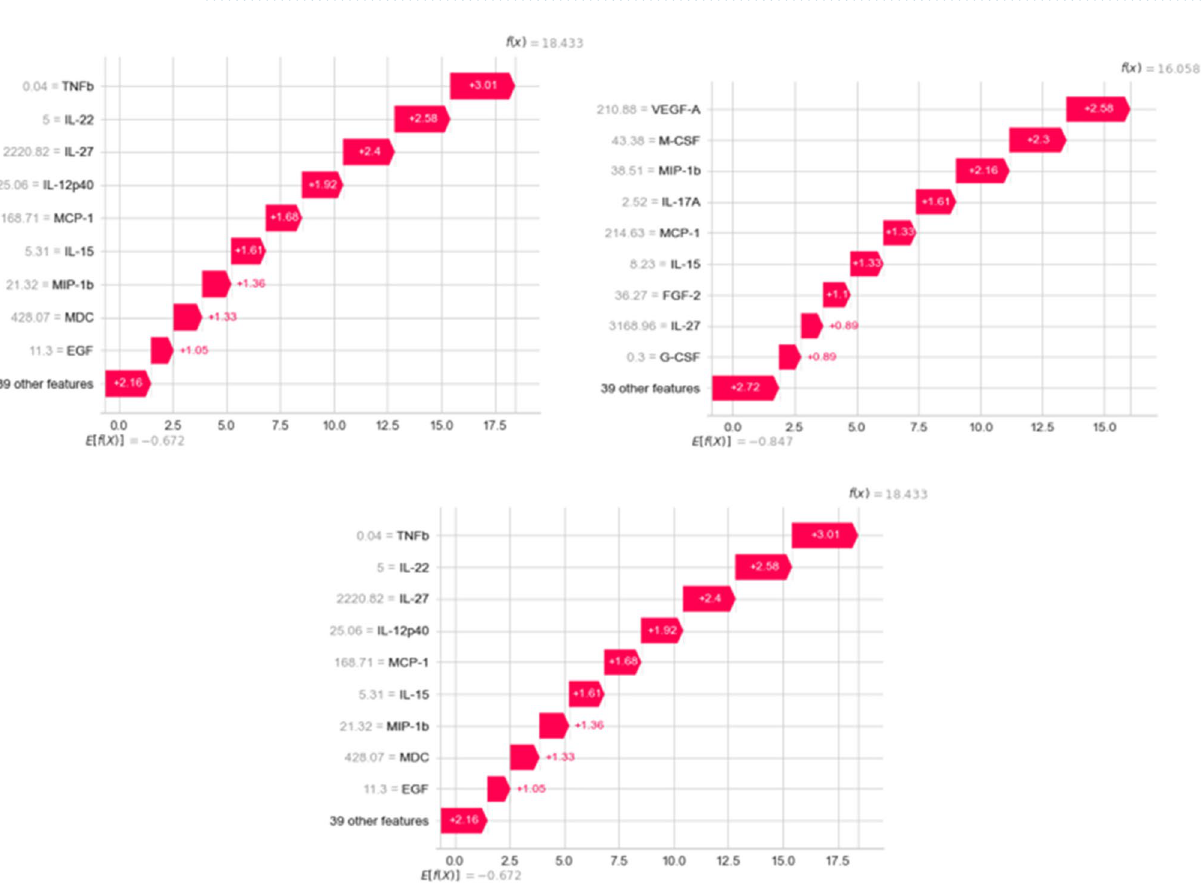
Figure 14. SHAP diagrams of characteristics with varying conditions: Healthy, Severe, and Non-Severe,